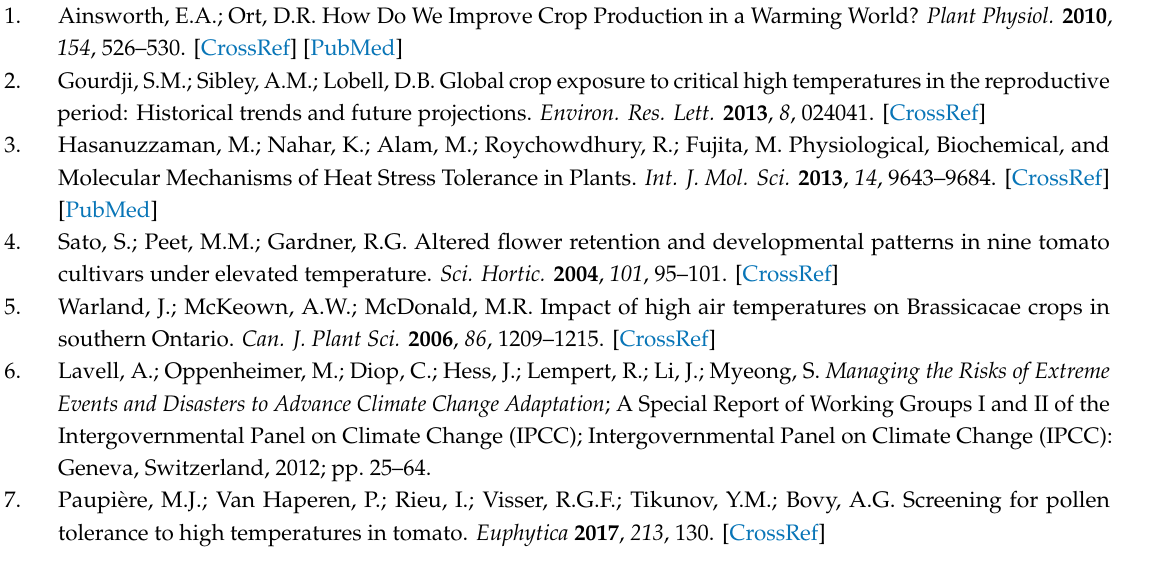
number of fruit / plant, FW = Fruit weight, YP = Yield / plant. Table S3: Three-way ANOVA for traits measured on 12 genotypes in two fields and two years. The level of significance ( p ) and the total sum of square percentage (TSS %) are reported. (* p < 0.05, ** p < 0.01, *** p < 0.001, ns = not significant). NFL = No. flowers / inflorescence, FS = Fruit set, TNF = No. fruit / plant, FW = Fruit weight, YP = Yield / plant. Table S4: Pearson’s correlation index among the five traits evaluated in four experimental fields. In bold are reported values significant at least for p < 0.05 (* p < 0.05, ** p < 0.01, *** p < 0.001). C2016 = Campania in 2016, C2017 = Campania in 2017, P2016 = Puglia in 2016, P2017 = Puglia in 2017. NFL = No. flowers / inflorescence, FS = Fruit set, TNF = No. fruit / plant, FW = Fruit weight, YP = Yield / plant. Table S5: Significative Pearson’s correlation index evaluated between four traits (NFL, FS, FW, TNF) and production level (YP) for each genotype. In orange: negative correlation index, in green: positive correlation index. NFL = No. flowers / inflorescence, FS = Fruit set, TNF = No. fruit / plant, FW = Fruit weight, YP = Yield / plant, Table S6: Mean and stability parameters for yield per plant of 12 genotypes averaged over two locations (Campania and Puglia) and two years (2016-2017). Stability parameters: b iv , linear regression coe ffi cient, ADL, average deviation from linearity, and r 2 , coe ffi cient of determination. For ADL (Average Deviation from Linearity), * p < 0.05 with HSD Tukey’s test. Table S7: List of the 201 genes with a moderate impact e ff ect on the protein structure. In bold, genes with private SNP variants for E42. For each gene, the position of the mutation in the tomato genome (version SL3.0), the genotypes carrying the mutation, the predicted e ff ect, and the protein function are reported Table S8. Percentage of identity of 63 private InDels for E42 with three wild tomato species. Markers coded S are SSR markers and coded N are InDels. For each mutation, the percentage of identity and the position on sca ff olds / contigs are reported for the related wild species’